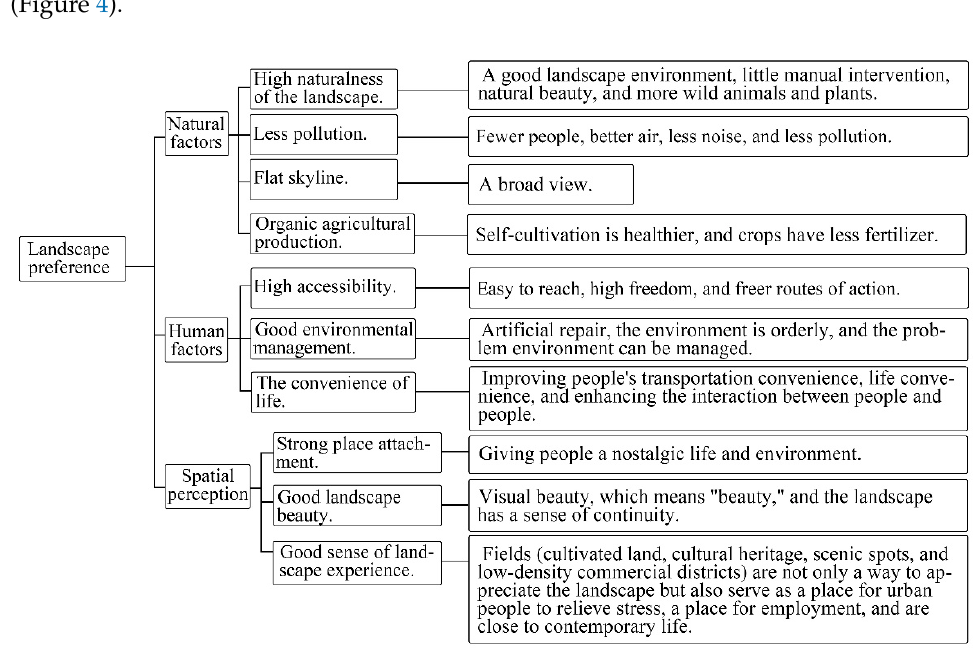
Figure 4. Classification and interpretation of residents’ preferred landscape.